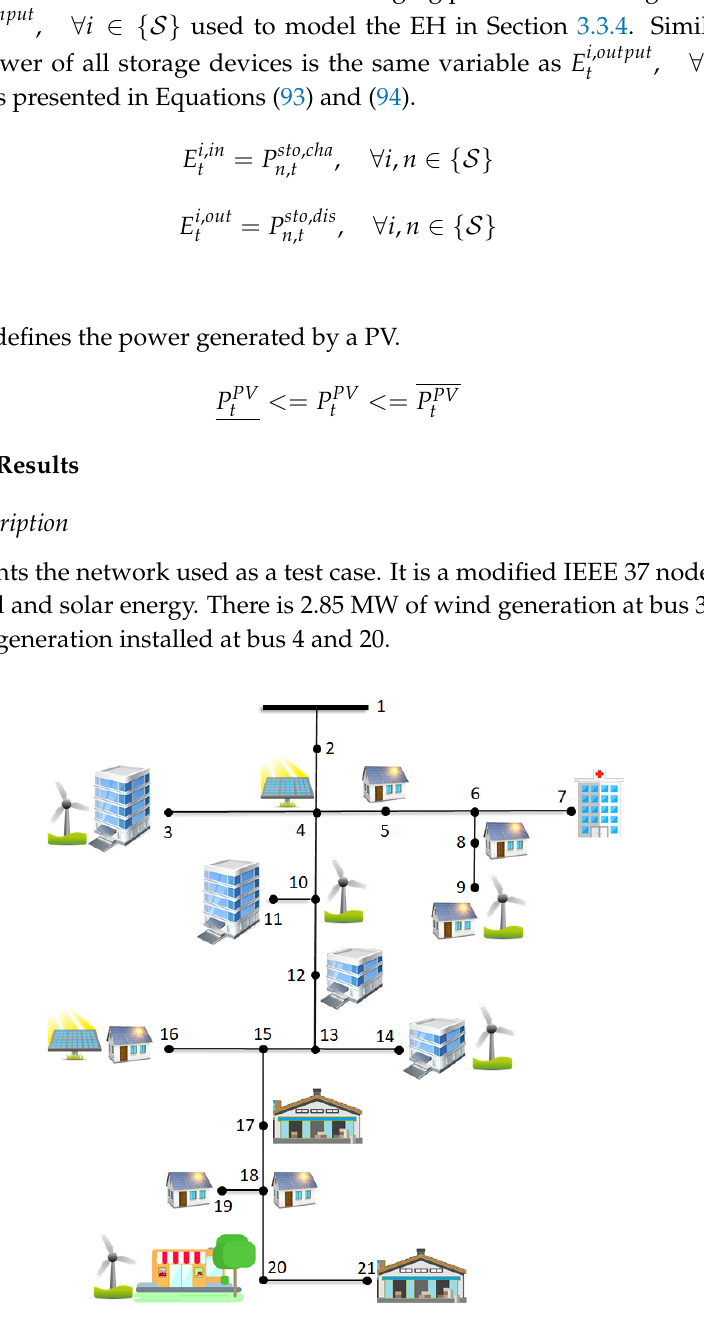
Figure 4. Adapted IEEE 37 node test